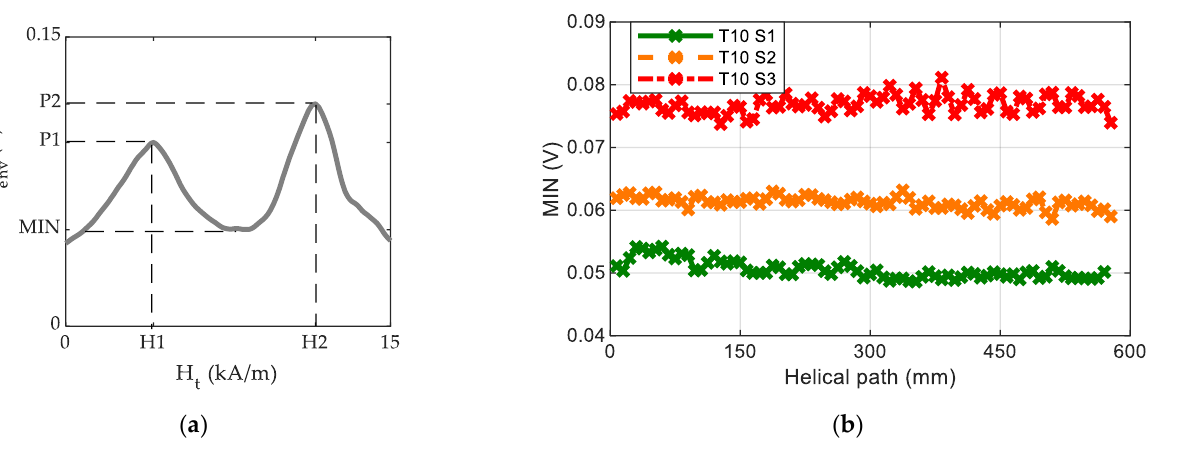
Figure 2. ( a ) Averaged MBN envelope (MBN env ) and the derived parameters and ( b ) the evolution of the minimum amplitude between the peaks of the MBN env (MIN) through the helical path of the ball screw’s thread.